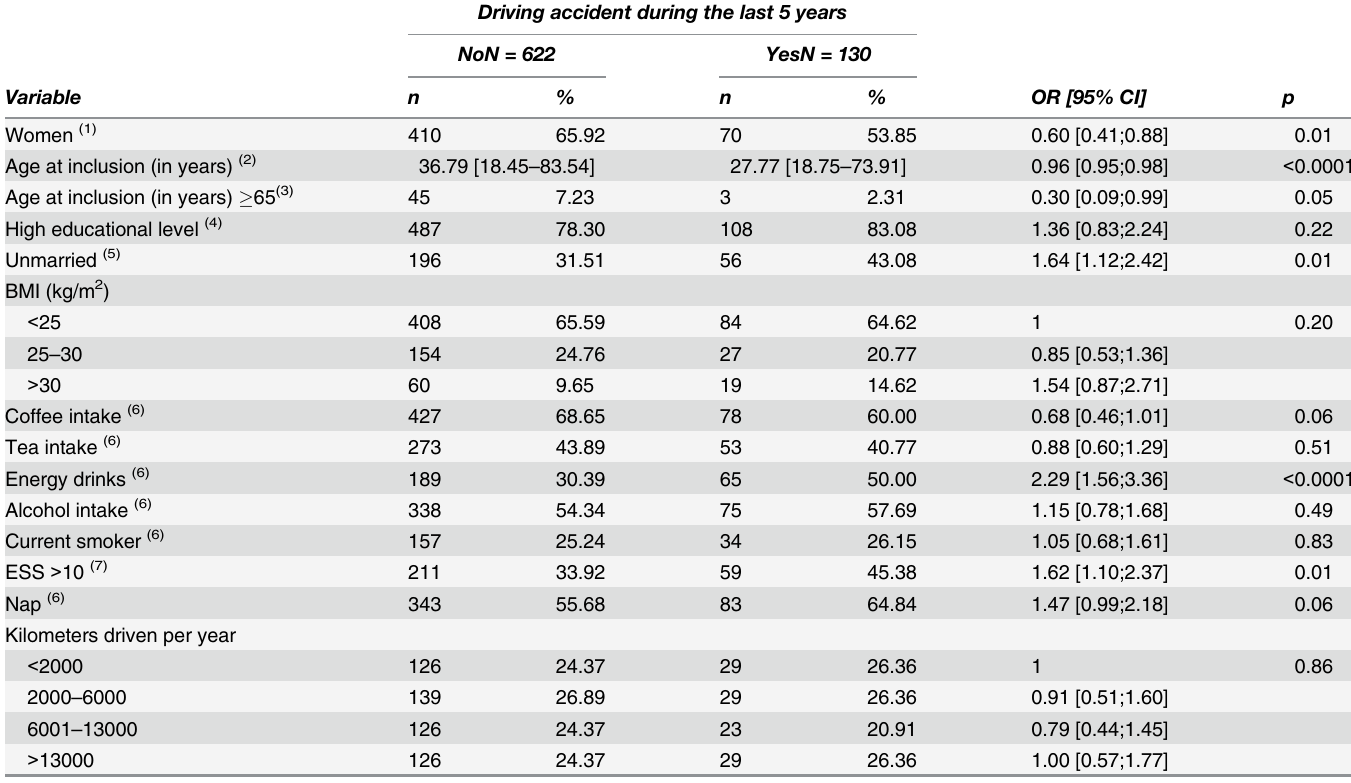
Table 2. Socio-demographic, health behaviour and health status factors according to driving accident during the last 5 years. Driving accident during the last 5